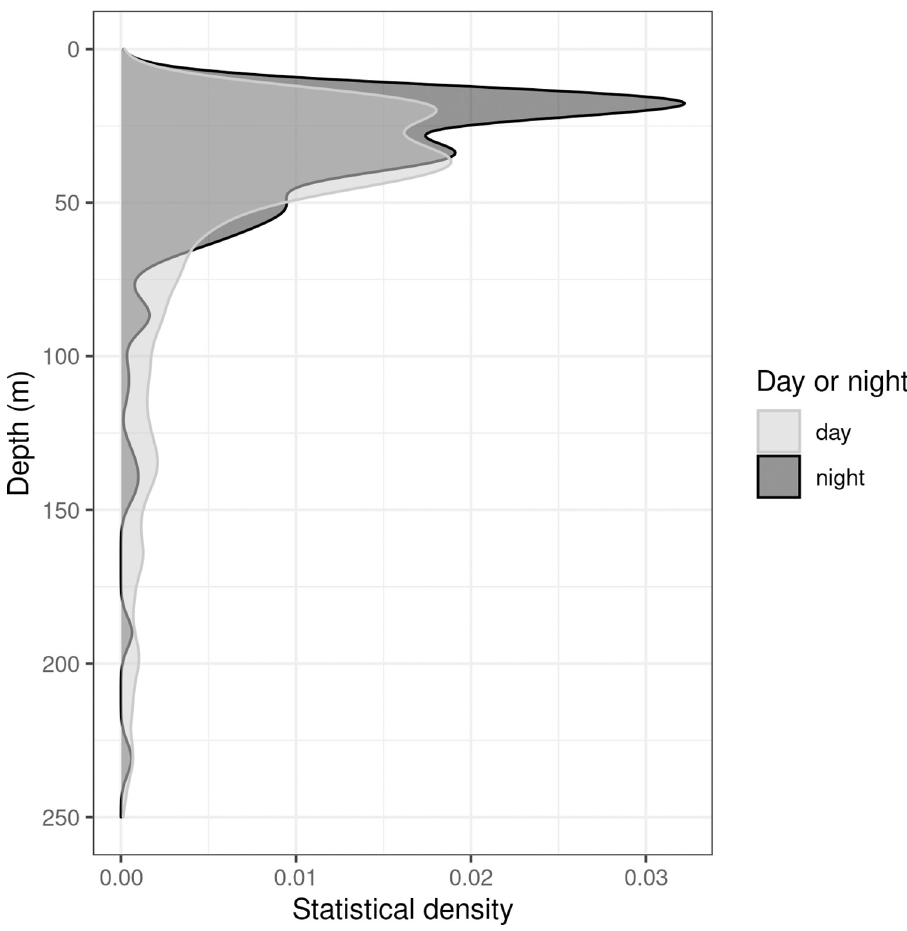
Fig 8. Distribution of krill swarms by water depth, split by day and